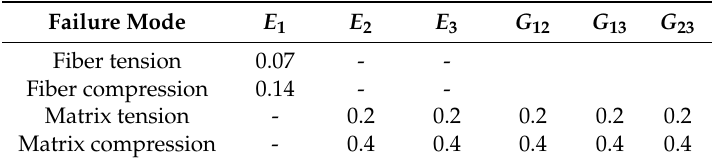
Table 3. Material properties to be degraded based on the mode of